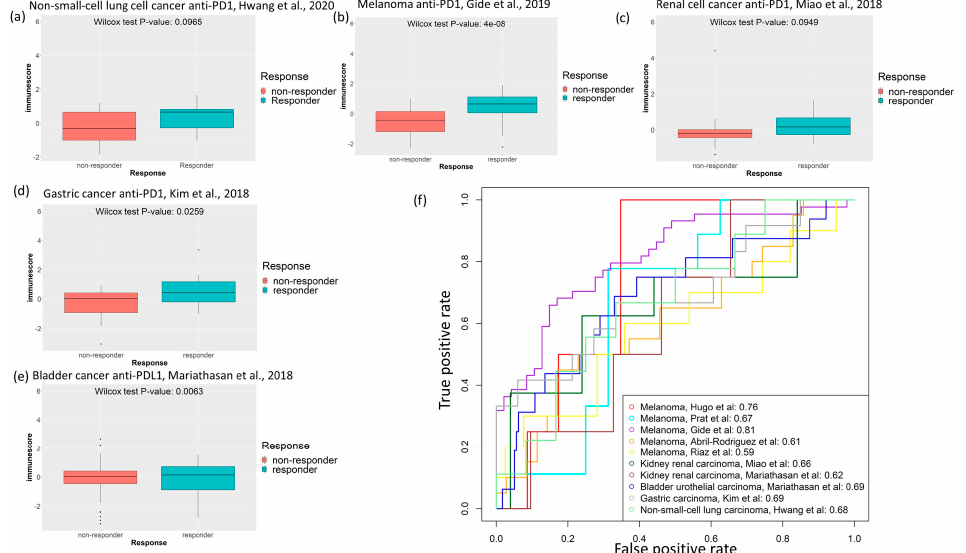
Figure 5. ( a – d ) Cancer-specific immune score is higher in patients with responsive tumors (CR / PR) than in patients with unresponsive tumors (SD / PD) in published data sets of anti-PD1- / anti-PDL1-treated tumors: ( a ) anti-PD1-treated non-small cell lung cancer [28], ( b ) anti-PD1-treated melanoma [22], ( c ) anti-PD1-treated renal cancer [26], ( d ) anti-PD1 treated gastric cancer [27], and ( e ) anti-PDL1-treated bladder tumors from the ImVigor210 trial [25]. ( f ) Immune score predicts objective response (RECIST) for anti-PD1 / anti-PDL1 immunotherapy in a published data set of di ff erent tumor types; patients with CR or PR are considered as having responsive tumors, while patients with SD or PD are considered as having unresponsive tumors. Receiver operating characteristic curve for cancer-specific immune score predicting objective response is shown for: anti-PD1-treated melanomas [20–24], anti-PDL1-treated bladder tumors from the ImVigor210 trial [25], anti-PD1 / PDL1-treated kidney tumors [25,26], anti-PD1 treated gastric cancer [27], and anti-PD1 treated non-small cell lung cancer